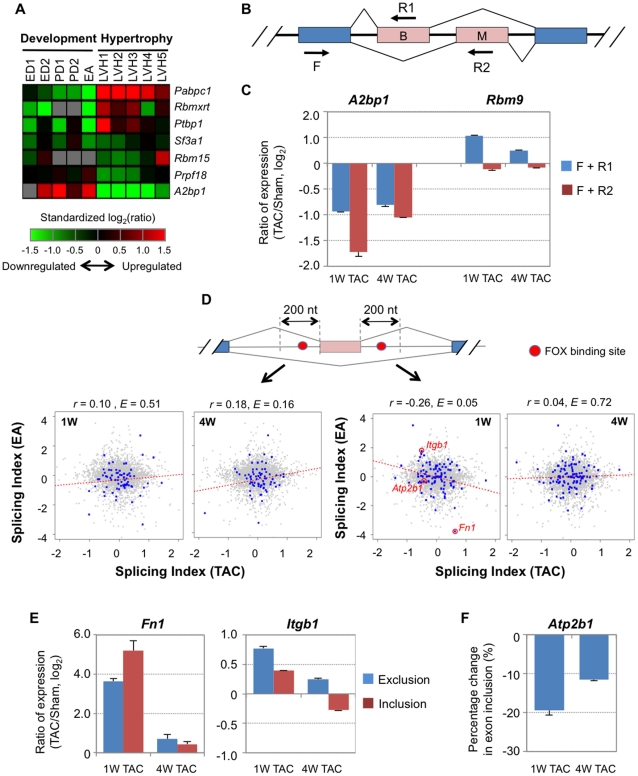
Regulation of splicing factors and Fox target exons in cardiac hypertrophy.(A) Gene expression analysis of splicing factors. Splicing factors are those reported in [38], [39]. Selected genes had fold change >1.5 and P<0.05 (T-test) in at least one of three 1 W TAC samples and had the same direction of regulation across samples. Genes are shown in a heatmap with color representing standardized log2(ratio) based on the color scale shown at the bottom. Grey indicates no detectable expression or not present on microarray. (B) and (C) Regulation of tissue-specific exons in A2bp1 and Rbm9. ‘B’ and ‘M’ represent brain- and muscle-specific exons, respectively, which are expressed in a mutually exclusive manner. Constitutive exons are in blue and alternative ones are in red. Arrows indicate forward (F) and reverse (R) primers for qRT-PCR. Expression changes are based on comparison with Sham samples. Error bars are standard error of the mean (SEM). (D) Splicing regulation for skipped exons with the Fox binding site (TGCATG) located in the upstream or downstream intronic regions adjacent to the exon. Only conserved Fox binding sites were used (see Materials and Methods for detail). Pearson Correlation coefficient and its E value are shown for each graph. (E–F) Experimental validation of skipped exons with Fox binding sites in the downstream intronic region. See Figure S5 for their exon structures. Exon 25 of Fn1 and exon 17 of Itgb1 were analyzed by qRT-PCR and exon 21 of Atp2b1 was examined by semi-quantitative PCR.